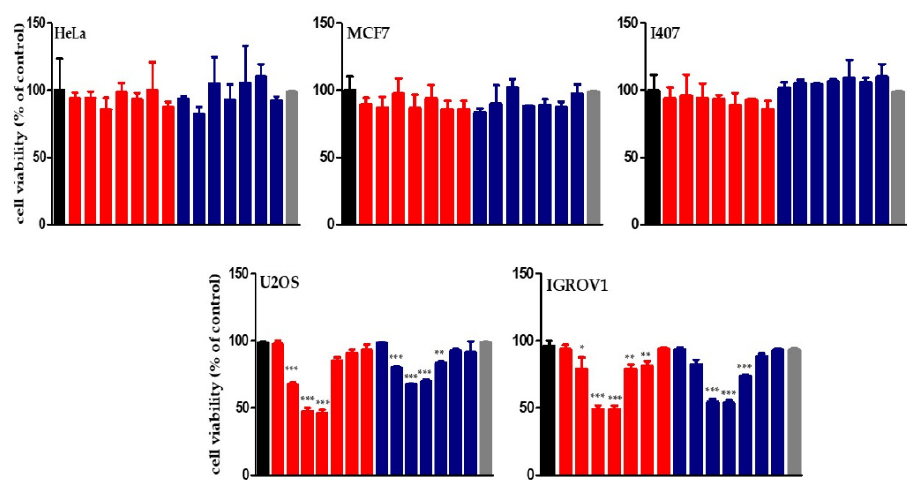
Figure 2. Effect of chloroformic extracts on the proliferation of neoplastic and normal human cell lines. HeLa, MCF7, I407, U2OS or IGROV1 cells were incubated for 24 h with increasing SCH (red) or SCO (blue) concentrations (1.25, 2.5, 5, 25, 50, 100, 250 μ g/mL). The black bar corresponds to control cells; the gray bar to IGROV1 treated with DMSO 0.5%. Proliferation was evaluated by the MTT test, as reported in Materials and Methods. Results are expressed as means ± SD of three independent experiments. Statistical analysis was performed by Dunnett’s multiple comparison test following one-way ANOVA. * p < 0.05, ** p < 0.01 *** p < 0.001, significantly different from control cells.